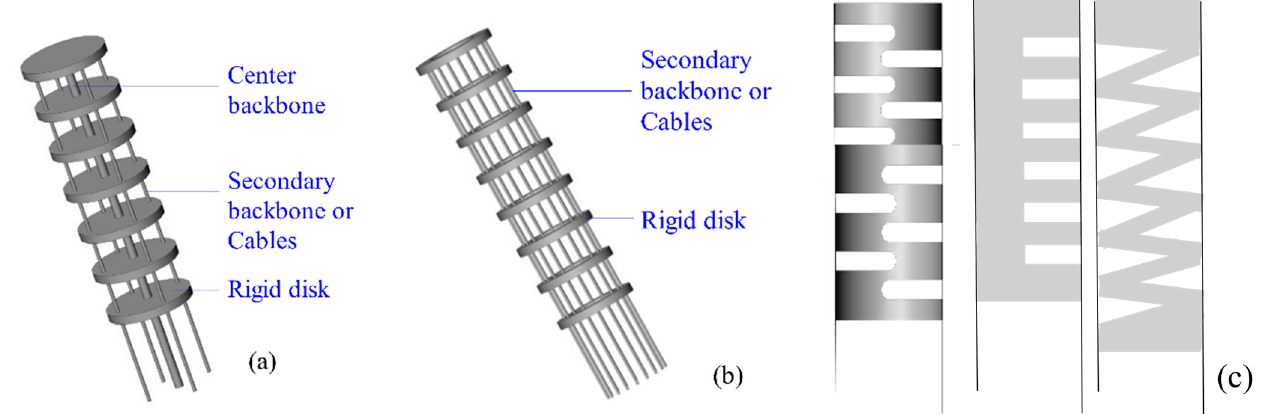
Figure 4. Backbone CCRs: ( a ) A robot with a centre backbone [1,51–53], ( b ) a robot without a central backbone [39] and ( c ) notched backbones [48].